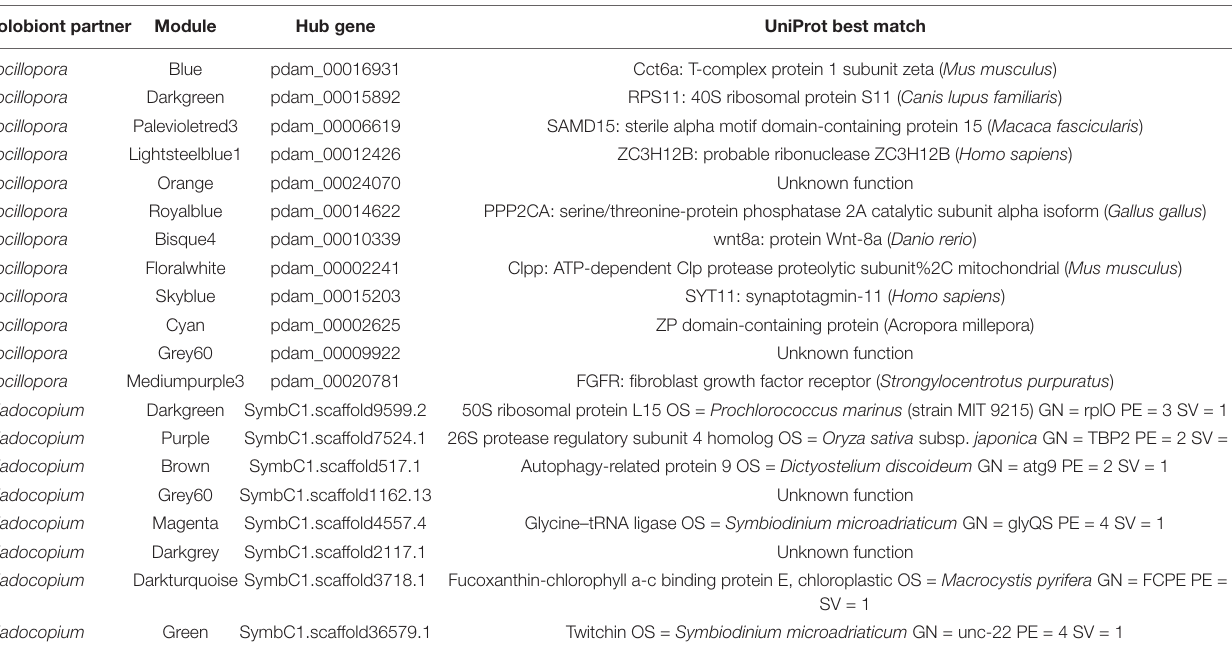
TABLE 3 | Hub genes of Pocillopora and Cladocopium WGCNA modules with significant correlations to experimental treatments. Holobiont partner Module